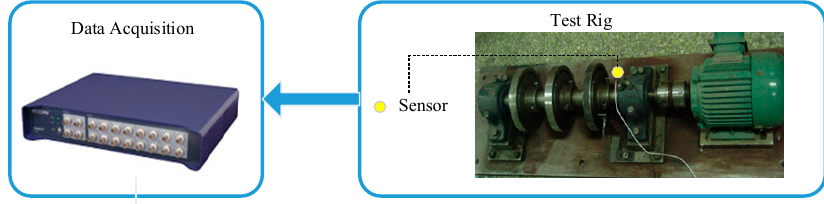
Figure 12. The experimental bench system.